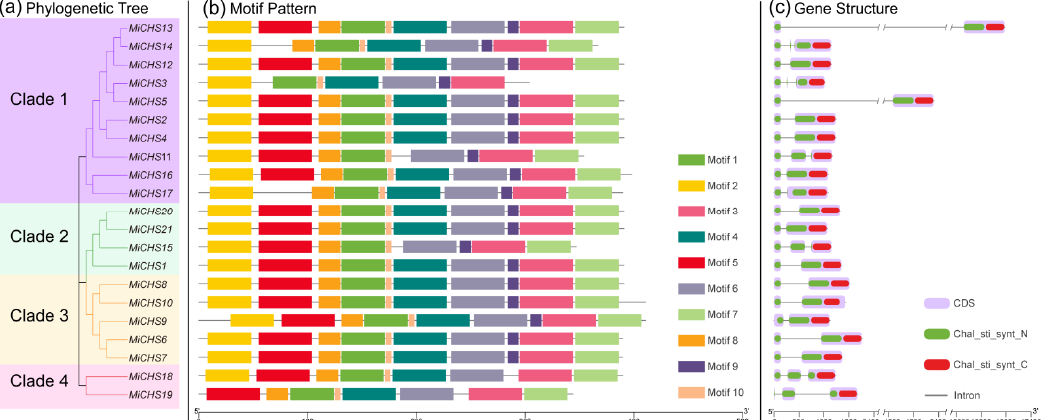
Figure 2. Phylogenetic tree, motif pattern and gene structure of CHS genes from the mango. ( a ) Based on the complete sequence of mango CHS proteins, a phylogenetic tree was constructed using MEGA-11 software. Different colors are used to represent different clades. ( b ) Composition of the mango CHS protein motifs. Patterns numbered 1 to 10 appear in differently colored boxes. Sequence information for each subject is supplied in Supplementary File S1. The protein length can be estimated using the following scales. ( c ) Gene structure of mango CHSs . Purple boxes denote coding sequences (CDS). The green and red regions represent the conserved domains of the MiCHS protein N-terminal and C-terminal, respectively, and black lines indicate introns.